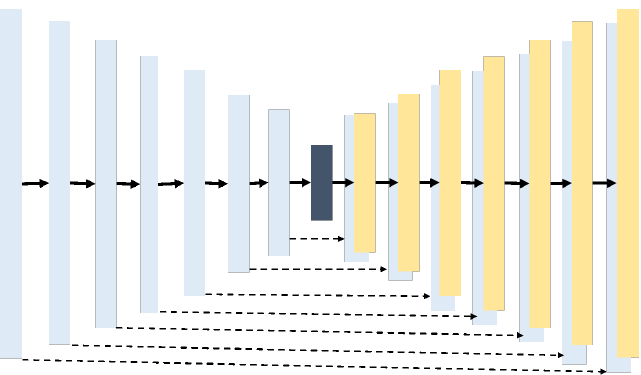
Figure 7. GAN architecture.